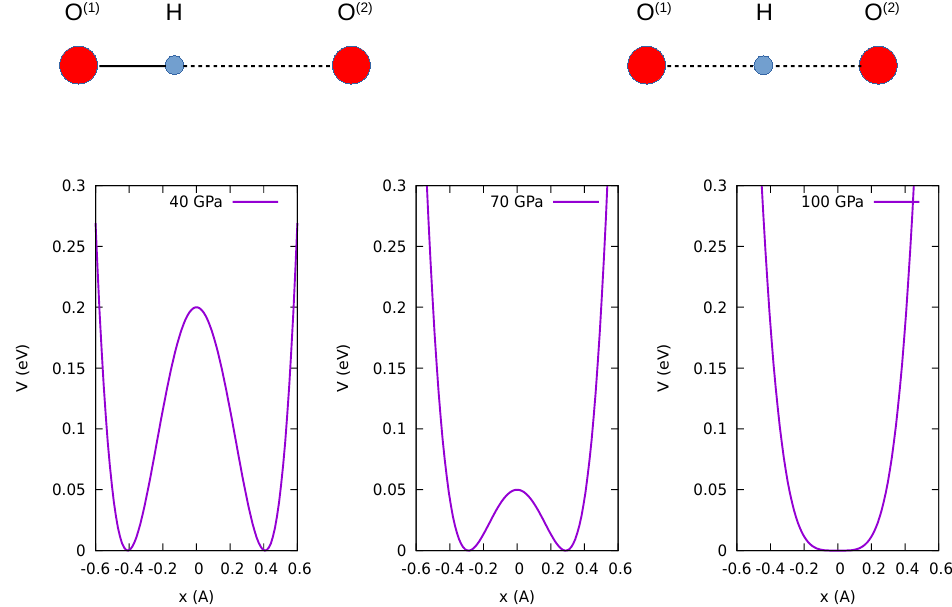
Figure 9. The proton effective potential energy V ( x ; P ) in Equation (25) for ice under increasing pressure P . The variable x is the difference between the distances from H to its two O neighbors: x = d ( O ( 1 ) − H ) − d ( O ( 2 ) − H ) . At P = 40 GPa, the proton forms a short covalent bond and a long hydrogen bond ( left panel ); at P = 70 GPa, V ( x ; P ) is a double well, with a barrier height of the same order as the proton zero-point energy ( center panel ); at P = 100 GPa, according to the classical picture, V ( x ; P ) shows a single minimum at x = 0 and the two O–H bonds are equivalent ( right panel